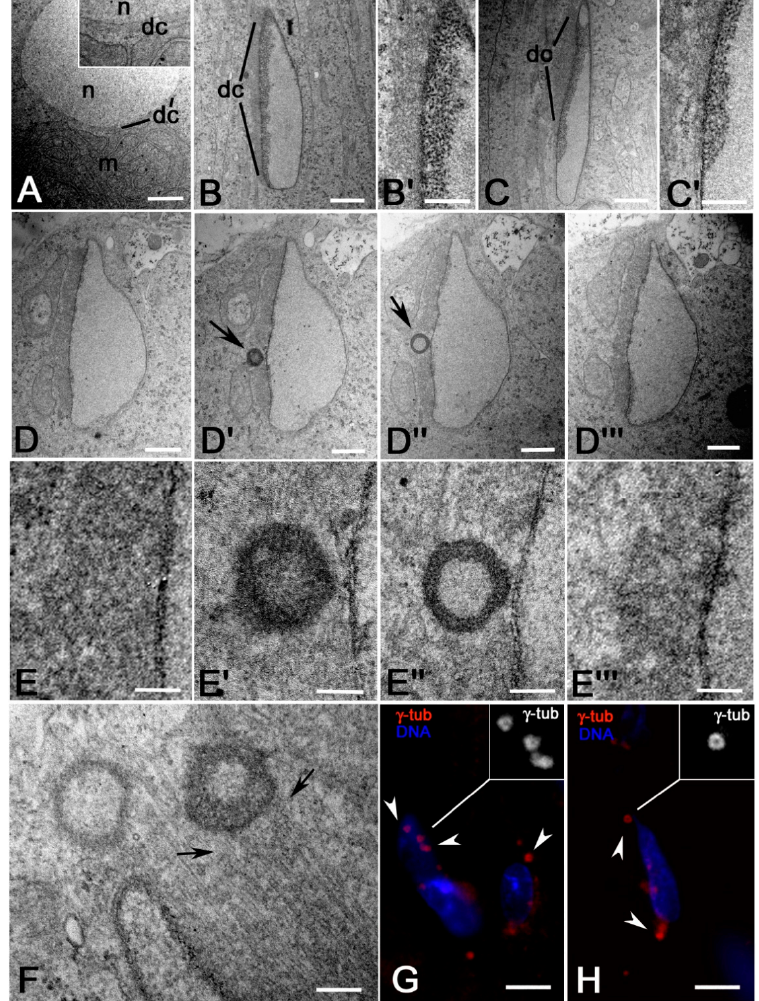
Figure 9. Dense complexes and MTs in Sas-4 mutant spermatids. ( A ) Onion stage spermatids: note the dense complex (dc) that surrounds the basal region of the nucleus ( n ) in front of the mitochondria (m) (inset). ( B , C ) Leaf stage nuclei and respective details ( B’ , C’ ): the dense complex (dc) has variable extension in correspondence of the condensed chromatin. ( D – D”’ ) Serial longitudinal sections of a leaf stage nucleus and corresponding details ( E – E”’ ): note the hollow spherical structures (arrows) inside the dense complex. ( F ) Section of the apical region of a leaf stage nucleus showing two hollow spherical structures from which nucleate several parallel MTs (arrows). ( G , H ) γ -tubulin localizes around the nuclei as small spots (arrowheads) that appear ring-shaped at higher magnification (insets). Scale bars: ( A – C , D – D”’ ), 1 µ m; ( B’ , C’ , E – E”’ , F ), 0.2 µ m; ( G , H ) 10 µ